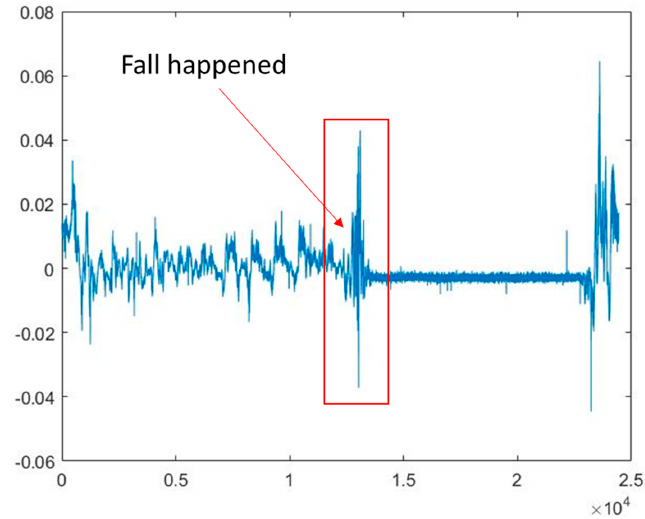
Figure 7. Correspondence between fall and CSI signal amplitude.